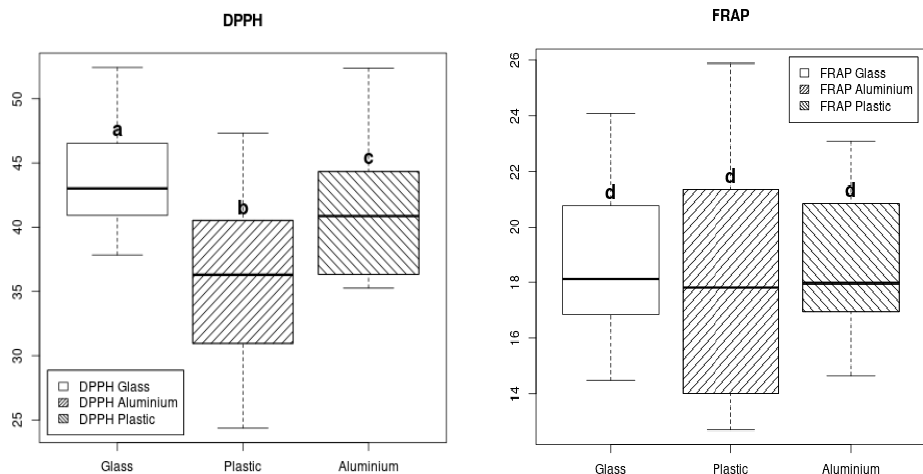
Figure 4. The box plot of DPPH ( left ) and FRAP ( right ) methods (mg GAE/L). According to ANOVA test, the significant statistical difference between the means for each type of container is marked by different letters ( p < 0.05).